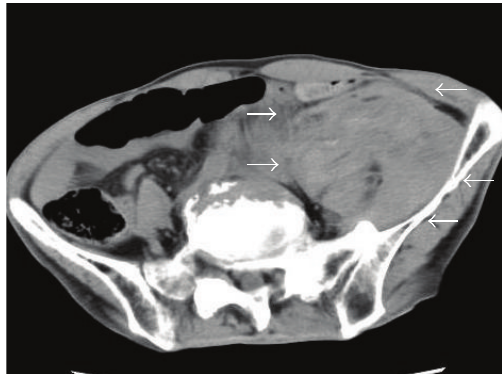
Figure 2: An abdominal CT showed about a 6cm hematoma in the retroperitoneal space